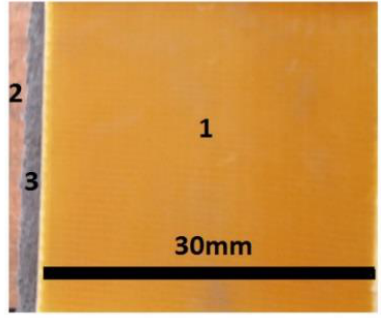
Figure 6. The components of electrical device: 1 — the surface of the epoxy resin board reinforced with glass fibers; 2 — copper foil; 3 — membrane M 𝑖 (𝑖 = 0,1, 2, 3) .